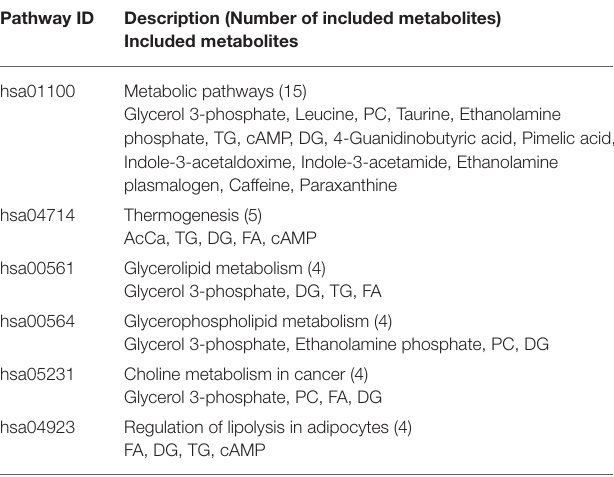
TABLE 2 | List of KEGG pathways that include 4 or more of the significantly differentiated metabolites in AD urine. Pathway ID Description (Number of included metabolites) Included metabolites